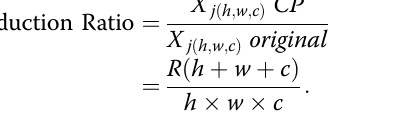
algorithm 1. In this study, the effect of attribute